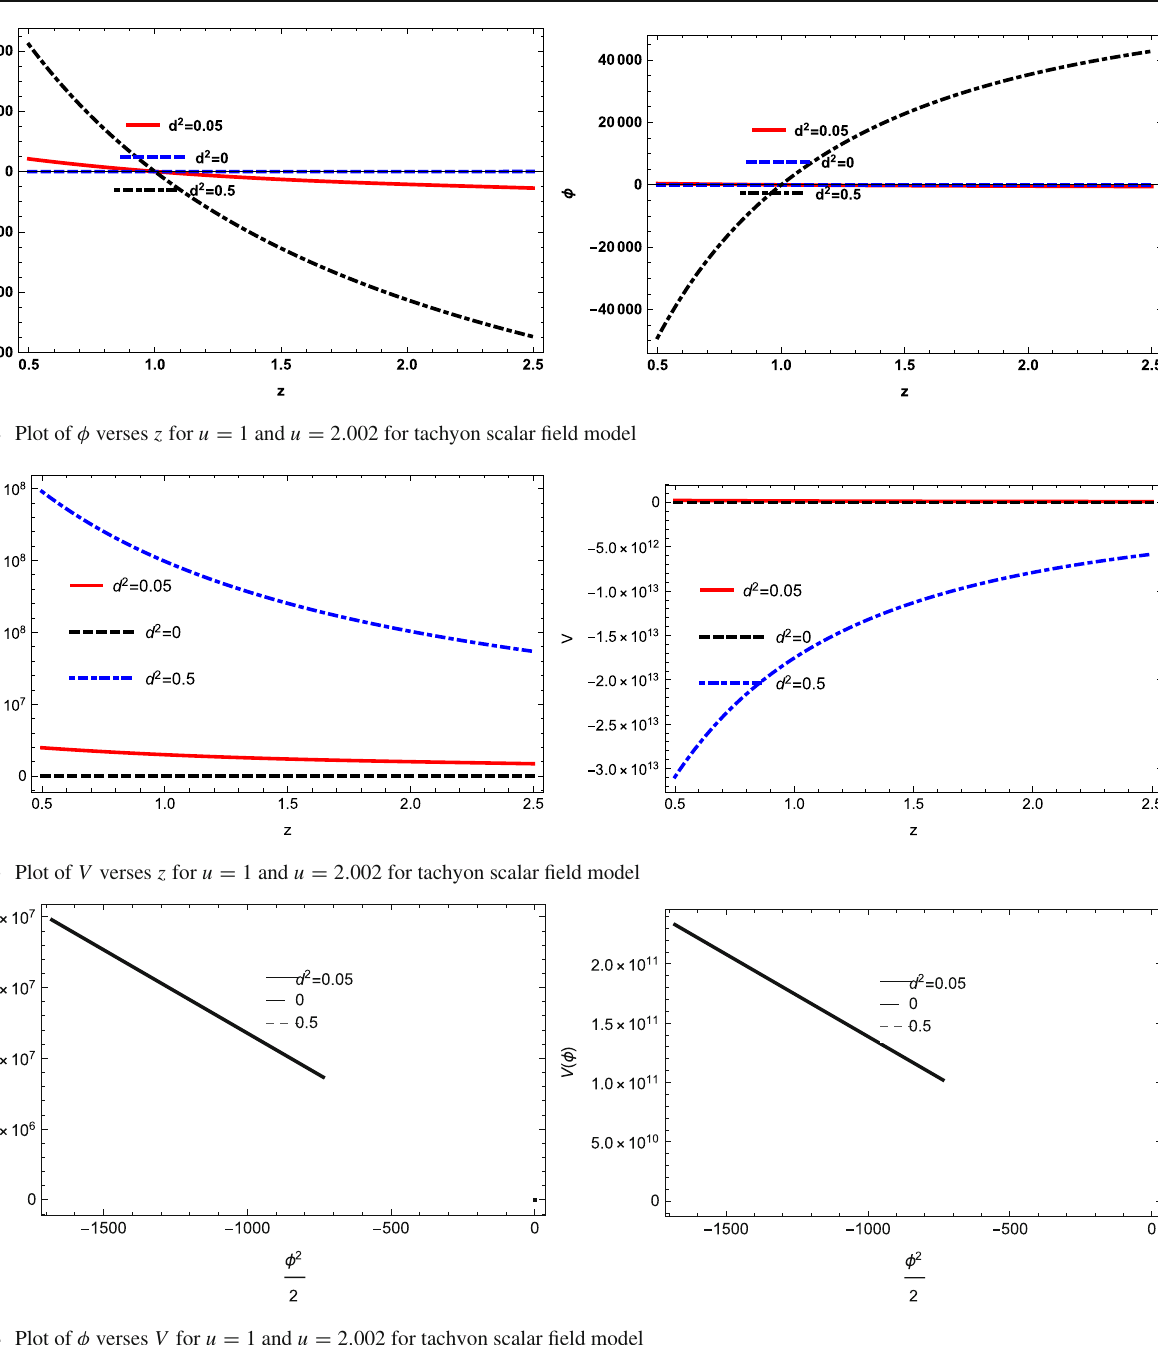
Fig. 24 Plot of φ verses V for u = 1 and u = 2 . 002 for tachyon scalar field